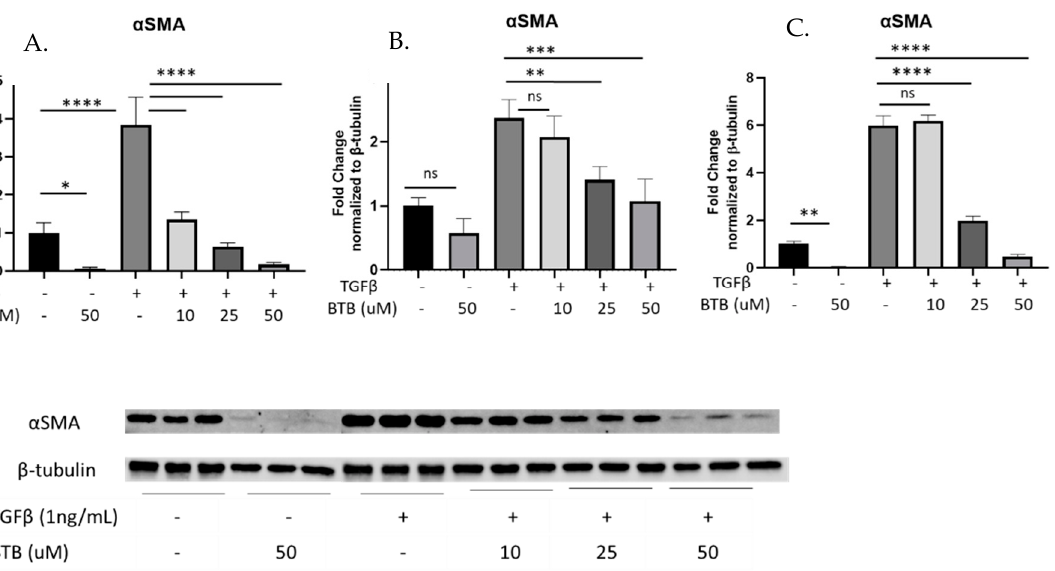
Figure 2. TDAG8 knockdown reduces the ability of TGF β to induce myofibroblast differentiation. Primary human lung fibroblasts were transfected with non-targeting control siRNA or siRNA spe- cific to TDAG8 for 16 h, upon which media was changed, adding 1 ng/mL TGF β where indicated, and harvested after 80 h. Lysates were examined for the expression of TDAG8, α SMA and collagen 1 at baseline ( A – C ) and in response to TGF β ( D – F ). Data were analyzed by t -test, in the case of two groups, or ANOVA where there are multiple groups. n = 3/group. ** p < 0.01, *** p < 0.05 **** p < 0.0001.